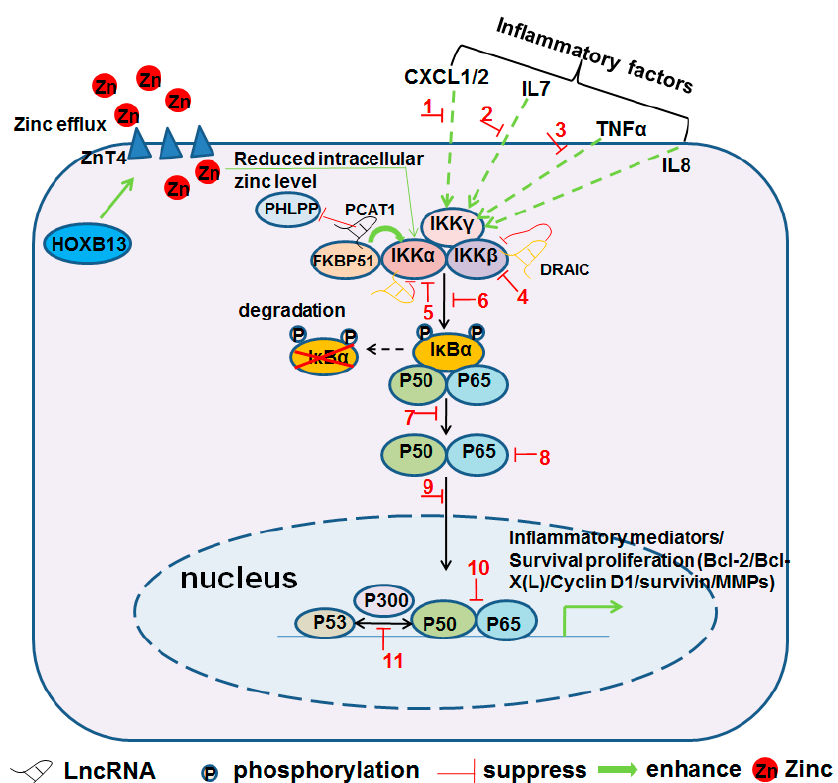
Figure 2. NF- κ B inflammatory signaling as a contributor to CRPC development and the therapeutic strategies for the suppression of CRPC by targeting NF- κ B inflammatory signaling. Note: 1: cur-